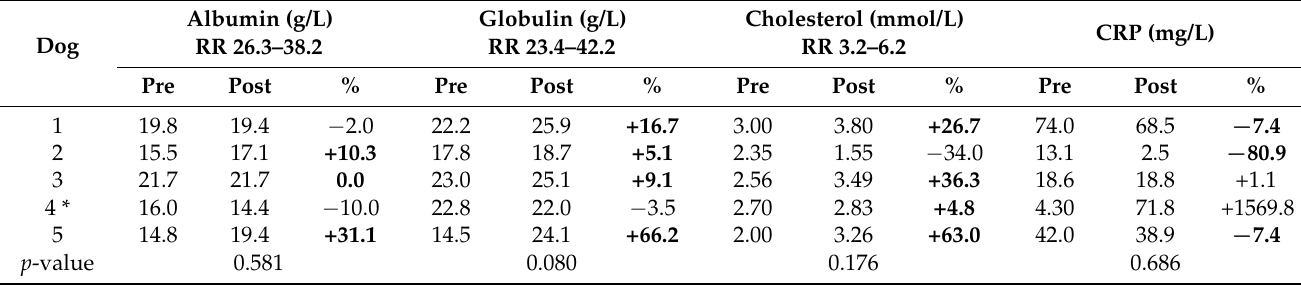
Table 1. Selected serum biochemical parameters for the five dogs diagnosed with inflammatory protein-losing enteropathy before (pre) and 2–3 days after (post) receiving the Modulen IBD liquid diet exclusively in-hospital without concurrent glucocorticoids. The percentage change (%) that were deemed to be beneficial are presented in bold. The p -value represents the results from the related- samples Wilcoxon signed rank test. CRP = C-reactive protein. RR = laboratory reference range. The * dog was subsequently diagnosed with primary hyperparathyroidism based on ionized calcium and serum parathyroid hormone (PTH) and PTH-related protein concentrations at the same